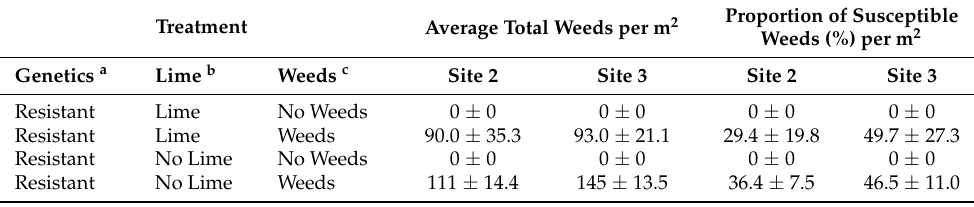
Table A2. Average total weed count per m 2 and proportion of clubroot-susceptible weeds per m 2 ( ± standard deviation) at two field sites in Edmonton, Alberta, 2019, treated with hydrated lime for clubroot